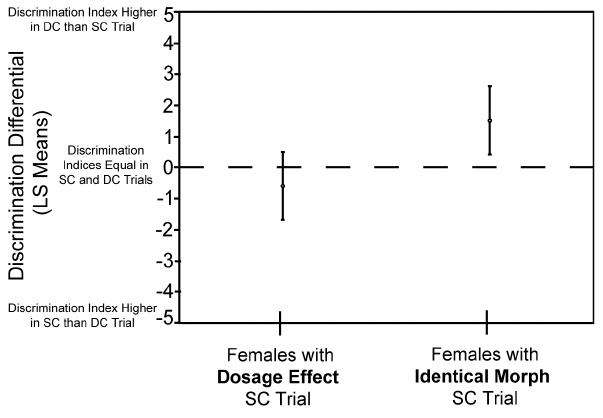
Figure 5. Least-squares (LS) mean discrimination differential was greater for females who participated in trial pairings with identical morph SC trials than for females in trial pairings with dosage effect SC trials. In addition, the LS mean discrimination differential was significantly greater than zero for females participating in trial pairings with identical morph SC trials but not for females participating in pairings with dosage effect SC trials. Circles represent LS means, while bars are 6 95% confidence intervals. Dashed line represents a discrimination differential of zero.